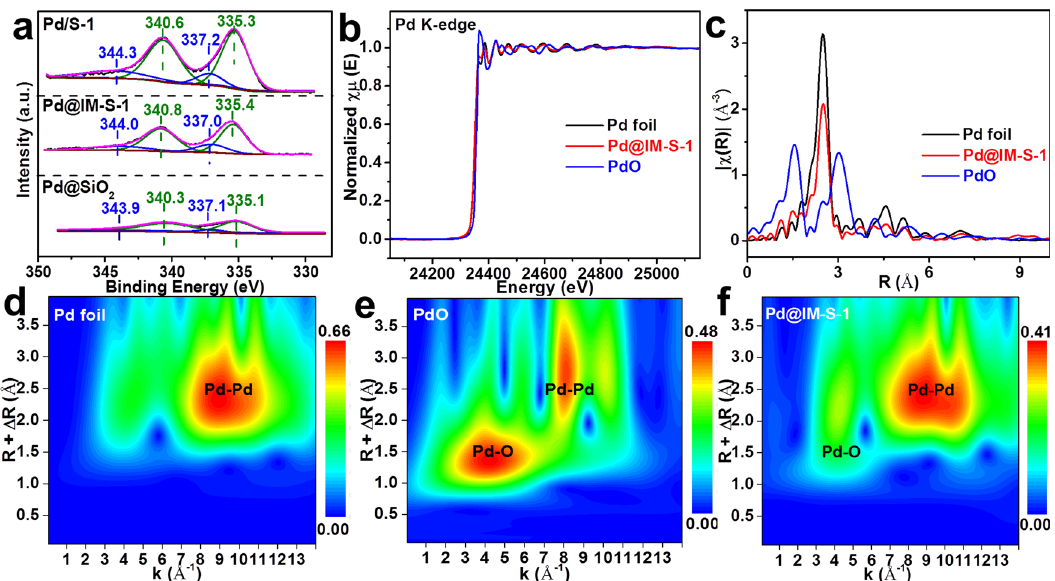
Fig. 4 Valence state and Pd-PdO interaction of Pd@IM-S-1. a XPS of Pd3d for Pd@IM-S-1, Pd/S-1 and Pd@SiO 2 ; b XANES spectra at the Pd K-edge; c Fourier transform of k3-weighted EXAFS spectra at the Pd K-edge; d − f the wavelet transforms from experimental data for Pd foil, PdO, and